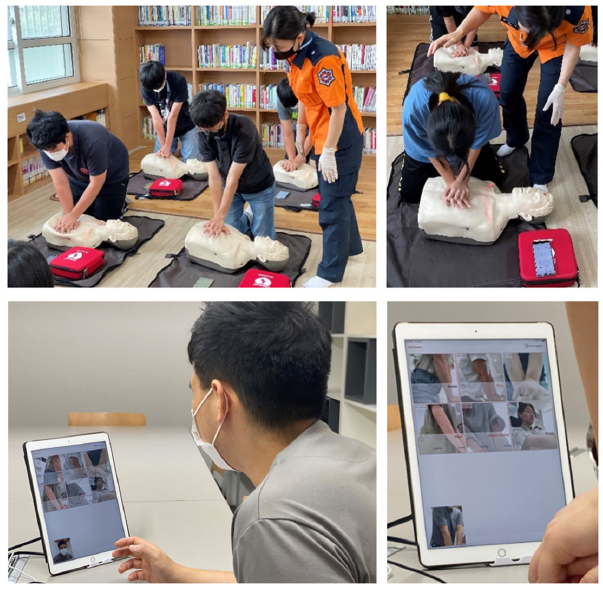
Figure 6. Face-to-face training group ( top ) and Remote training group ( bottom ).